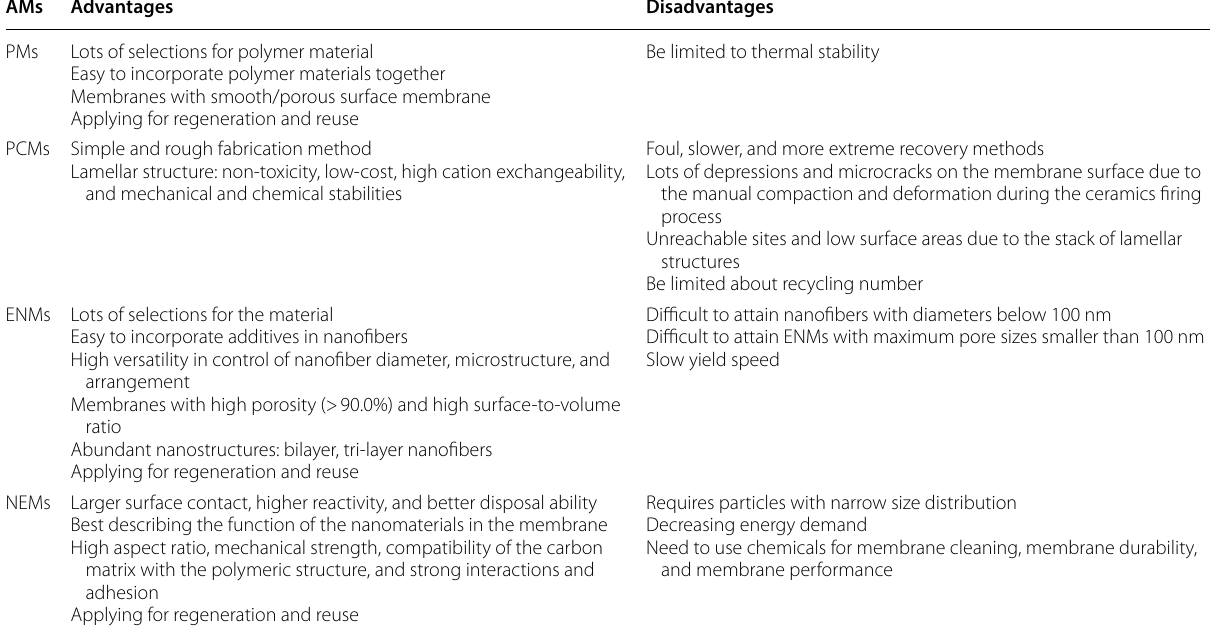
Table 1 Advantages and disadvantages of different AMs fabrication methods